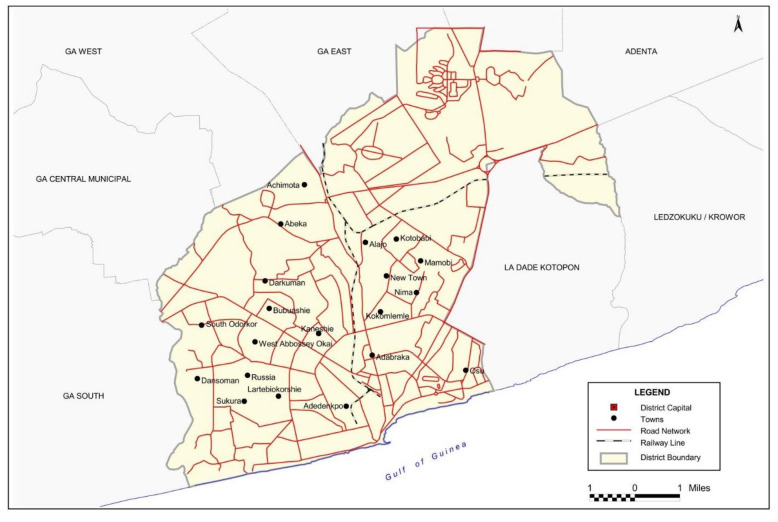
Map of study setting.